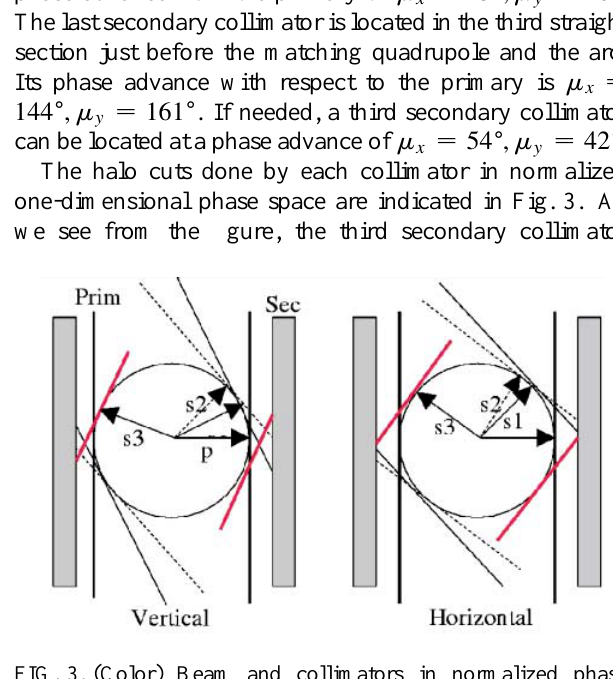
FIG. 3. (Color) Beam and collimators in normalized phase space. Secondary collimators cut the primary halo as it evolves following the phase